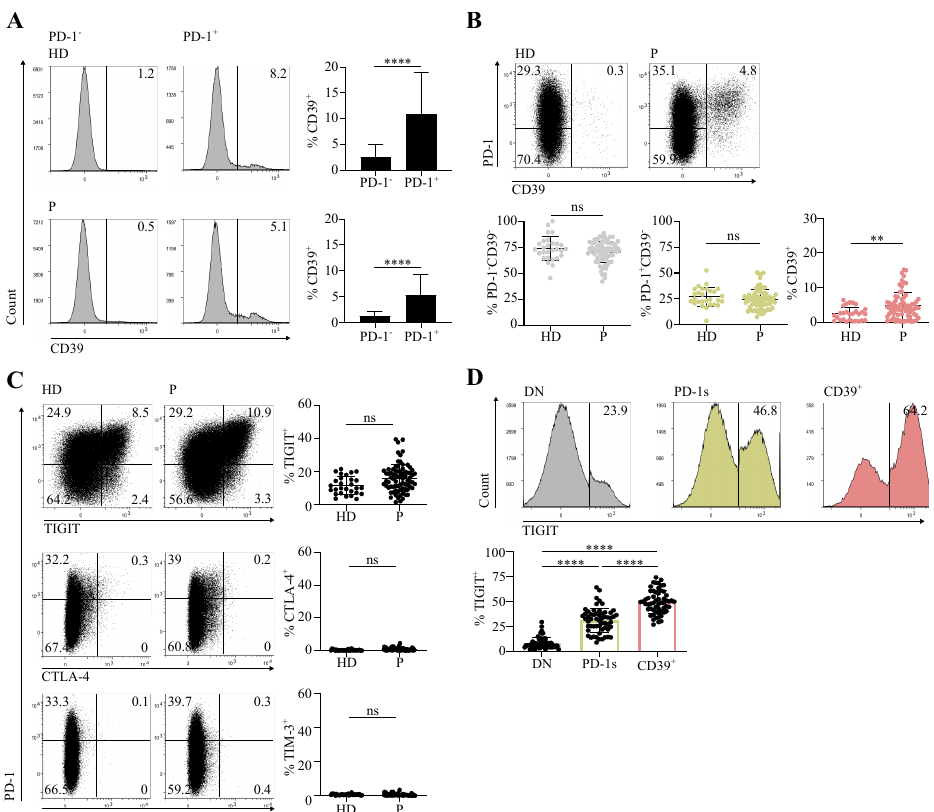
Figure 1. Circulating memory PD-1 + CD39 + CD4 T cells are found at increased proportions in cancer patients in comparison with healthy individuals. CD4 T cells sorted ex vivo from peripheral blood mononuclear cells (PBMCs) of healthy donors (HDs) and cervical cancer (CC) or head and neck squamous cell carcinoma (HNSCC) patients (P) at diagnosis were stained and analyzed by flow cytometry. Data are shown following gating on memory (CD45RA - ) conventional (FOXP3 - ) CD3 + CD4 + cells (memory Tconv, Supplementary Figure S1). ( A ) Examples of histograms showing CD39 expression in PD-1 - and PD-1 + memory Tconv populations and summary of the proportions of CD39 + cells among the two memory Tconv populations (HD, n = 28; P, n = 72). ( B ) Dot plots showing PD-1 and CD39 expression and summary of the proportions of the PD-1 - CD39 - , PD-1 + CD39 - , and CD39 + populations among memory Tconv (HD, n = 28; P, n = 72). ( C ) Dot plots showing expression of TIGIT, CTLA-4, and TIM-3 versus that of PD-1 and summary of the proportions of TIGIT + (HD, n = 28; P, n = 72), CTLA-4 + , and TIM-3 + (HD, n = 28; P, n = 63) cells among memory Tconv. ( D ) Histograms showing expression of TIGIT in the PD-1 - CD39 - (DN, double negative), PD-1 + CD39 - (PD-1s, PD-1 single), and CD39 + memory Tconv populations and summary of the proportions of TIGIT + cells in the three populations from patients ( n =